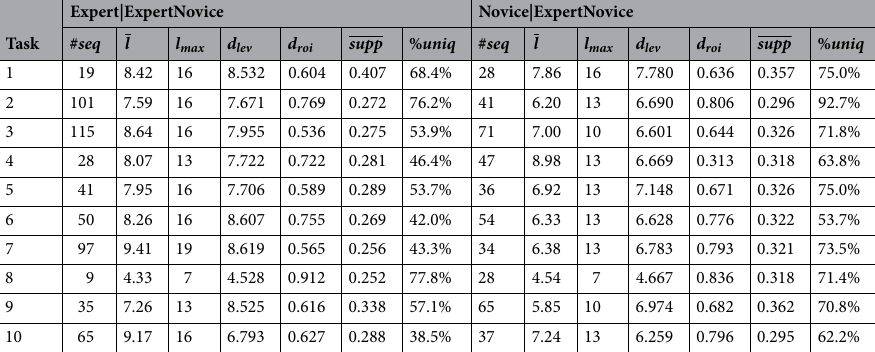
Table 3. The number of contrast patterns ( # seq ), average and maximum pattern lengths ( l , l max ), average pair- wise Levenshtein and ROI distance between patterns within a group ( d lev , d roi ), average support value ( supp ), and the percentage of patterns with infinity growth ( % uniq , unique subsequences for the group) of extracted contrast visual reasoning patterns for Expert and Novice groups in Expert vs. Novice